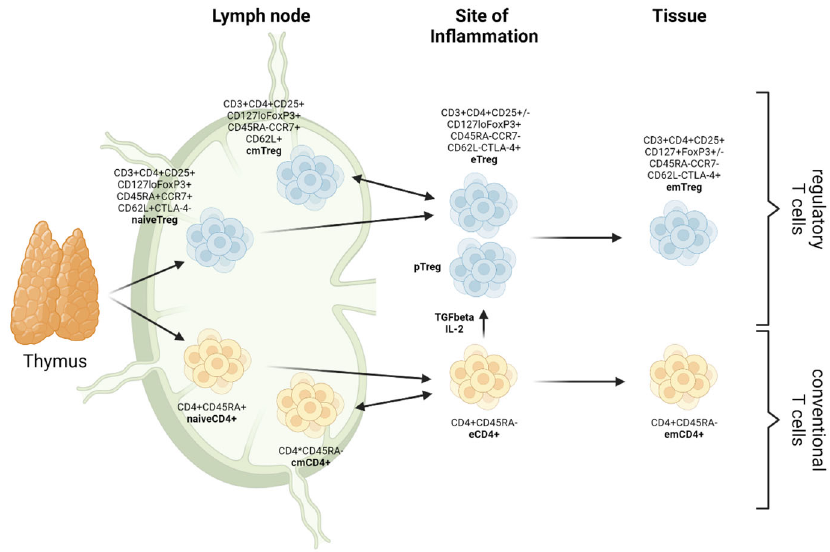
Figure 1. Differentiation dynamics and plasticity of (regulatory) T cells. cm: central memory; em: effector memory; e: effector; p: peripheral (created with biorender.com).